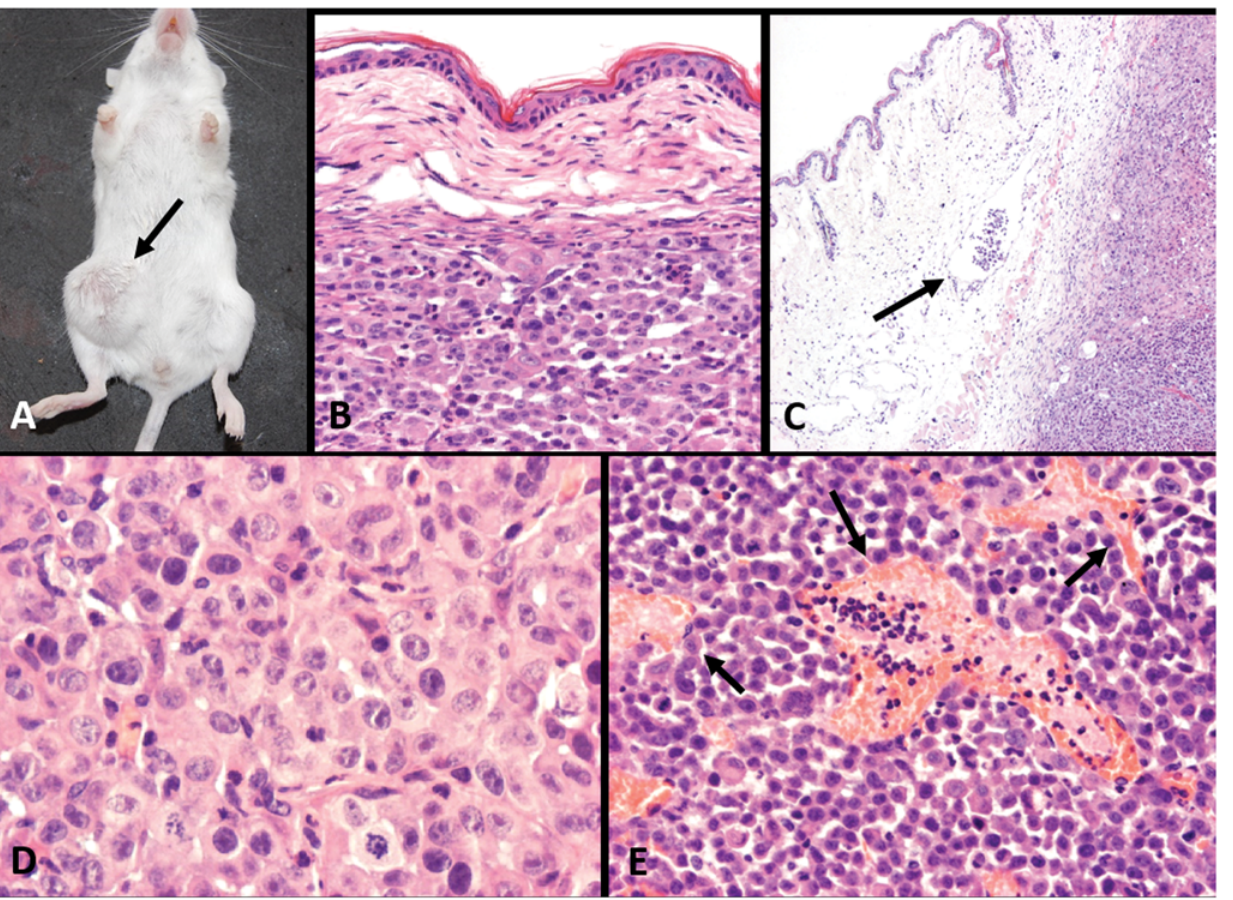
Fig 5. Tumors from mice inoculated with IPC-366. A) IPC-366 mouse xenografts at four weeks (arrow). B to E: tumor paraffin sections H&E. B) Solid tumor infiltrating the dermis (10X). C) Neoplastic embolus in a superficial dermal lymphatic vessel (arrow) and solid tumor; marked edema in dermis (4X). D) Highly malignant tumor cells with marked anisocytosis and anisokaryosis; evident nucleoli (40X).E) Microvascular channels lined up by neoplastic cells (vasculogenic mimicry, arrows) (20X).